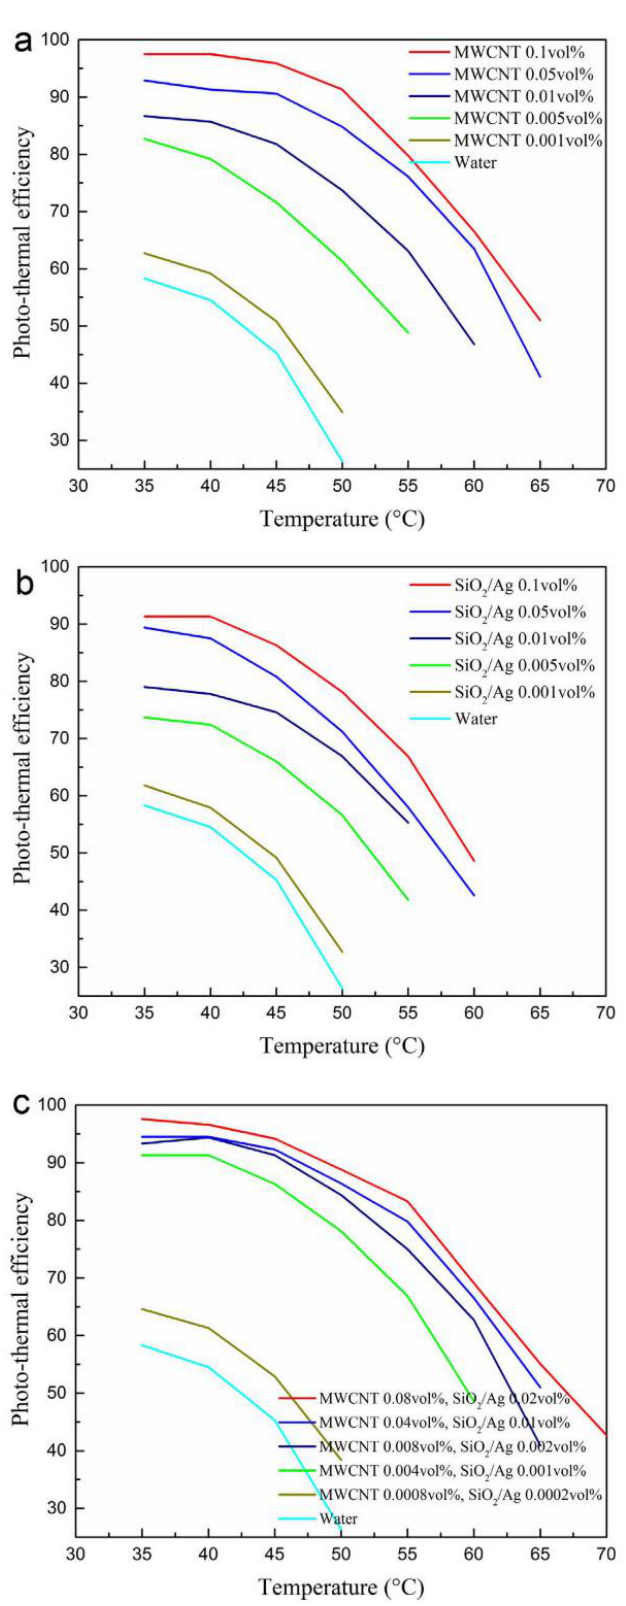
Figure 13. Calculated photothermal efficiency of nanofluids: ( a ) multi-walled carbon nanotubes (MWCNT) nanofluids, ( b ) SiO 2 /Ag nanofluids, and ( c ) binary nanofluids with MWCNT:SiO 2 /Ag = 4:1 [14]; 2018, Elsevier.